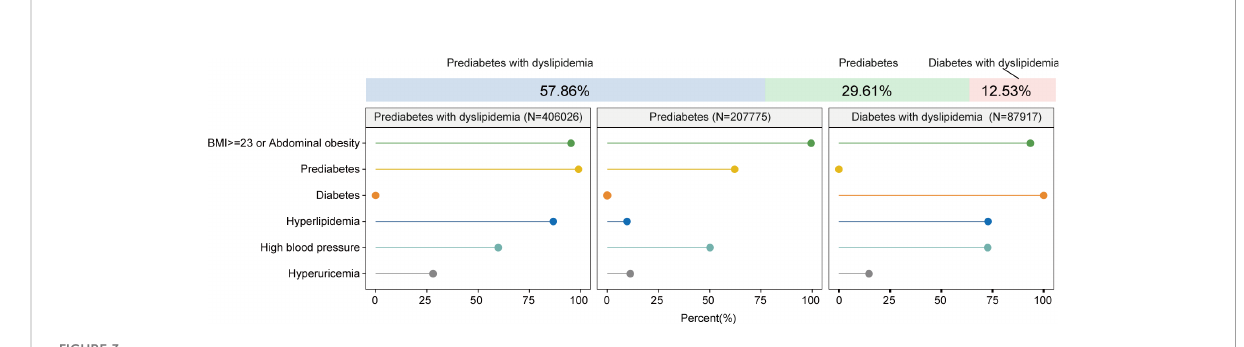
FIGURE 3 Probabilistic distribution of metabolic dysregulation in MAFLD